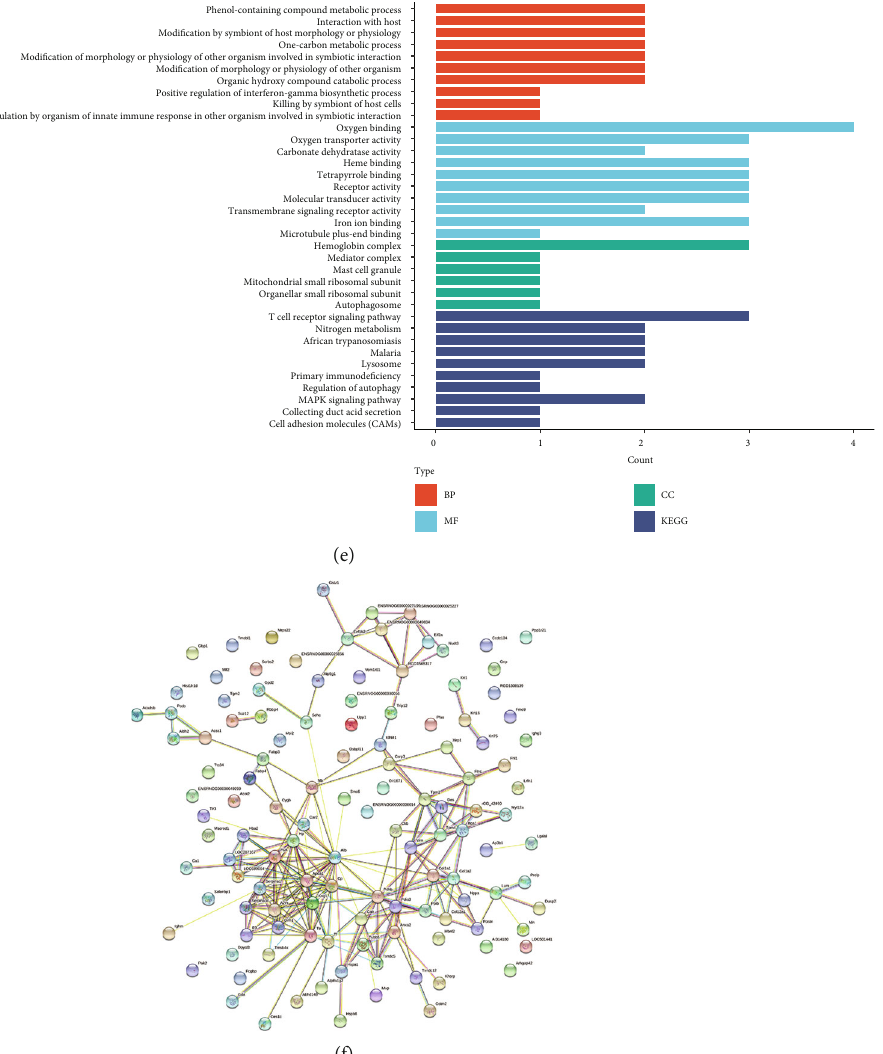
Figure 2: (a) Histogram of upregulated and downregulated DEPs. Upregulated DEPs were in grey, and downregulated DEPs were in yellow. (b) The heatmap and cluster analysis of DEPs. Upregulated DEPs were in red, and downregulated DEPs were in green. (c) Volcano plot representation of DEPs. A: upregulated proteins; B: downregulated proteins; and C: unchanged proteins. (d) GO enrichment and KEGG analysis of DEPs in the ISO/control and (e) ATH-1/ISO comparisons. The top 10 terms of BP, MF, CC, and KEGG analysis were displayed with the parameter protein count and P value. (f) Mapping of DEPs onto a composite network based on predicted protein- protein interaction. A predicted PPI network has been visualized for the identi fi ed